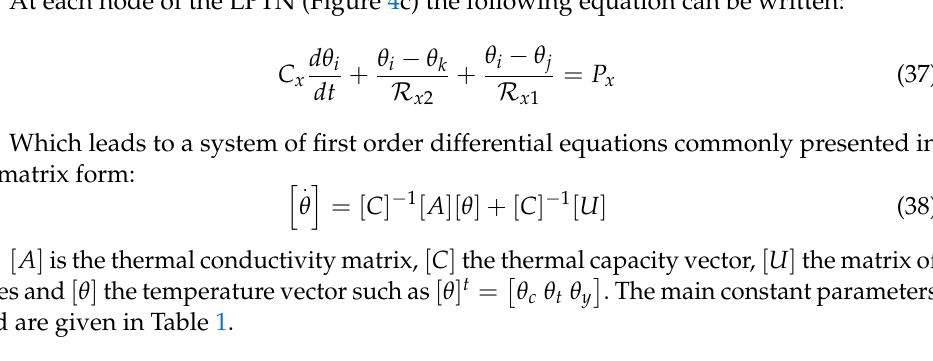
Table 1. Constant parameters for thermal